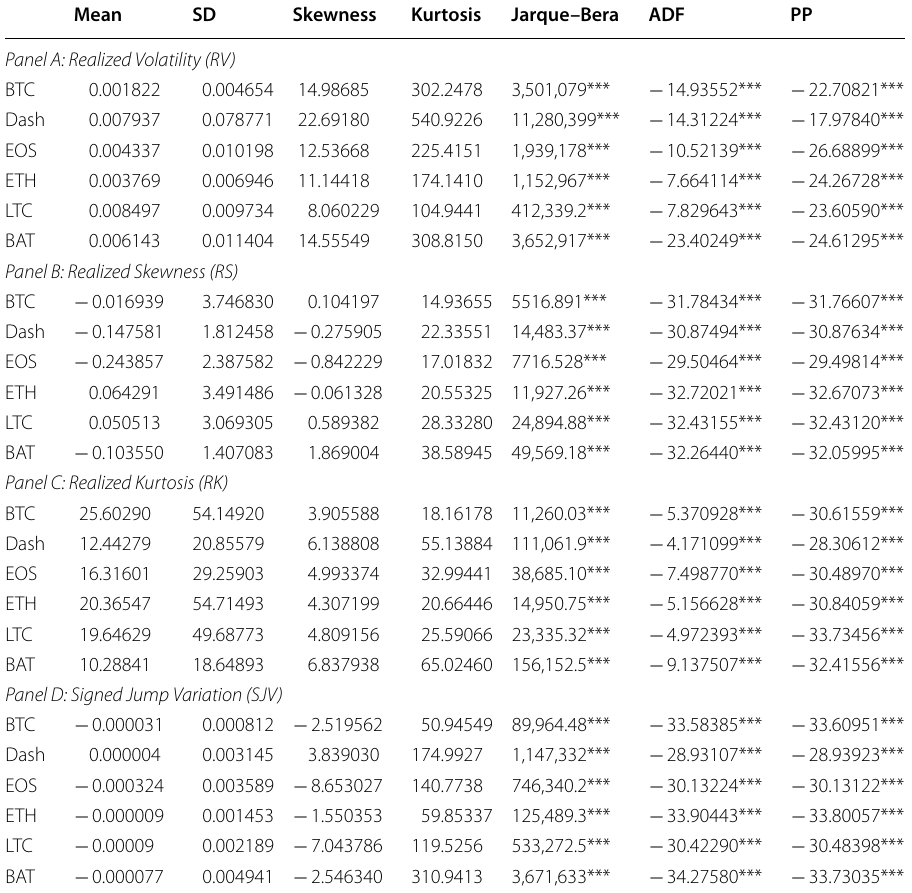
Table 1 Descriptive statistics of daily realized